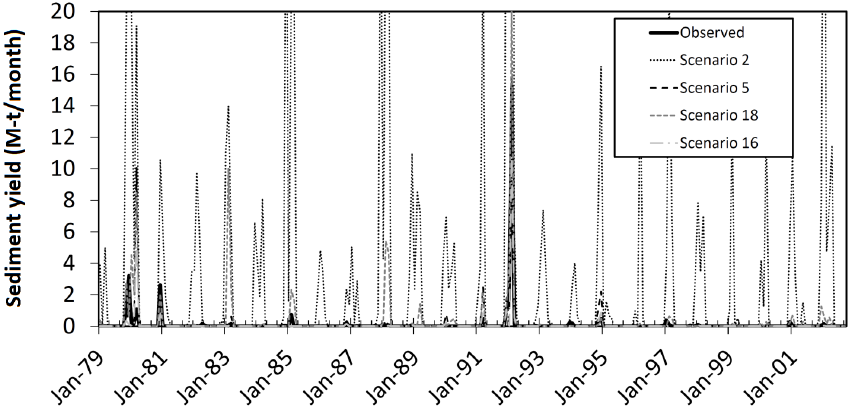
Figure 10. Simulated and observed monthly sediment yield (Mtmonth − 1 ) for scenarios 2, 5, 18 and 16.